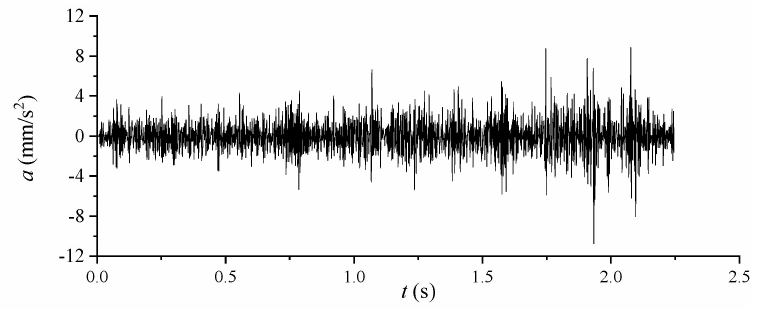
Figure 11. Filtered signal of mid-span acceleration at a speed of 20 km/h.